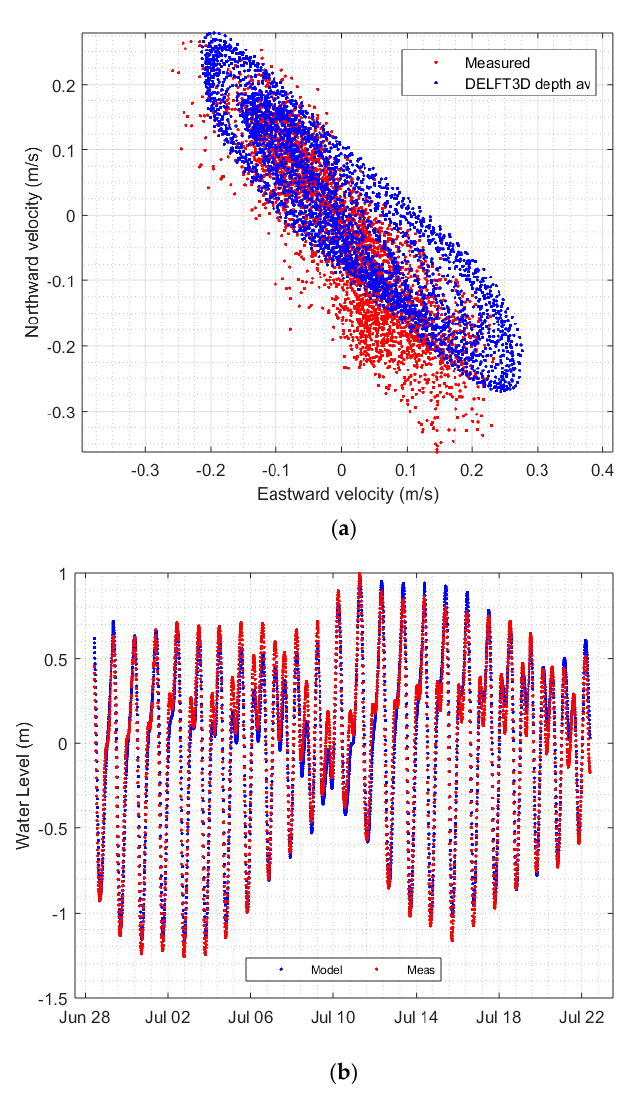
Figure 6. ( a ) Northward and eastward velocities measured by the ADCP at 10 m depth (same current meter as [21]; red) and depth averaged predictions by Delft3D for the same times (blue), ( b ) longshore velocities: Delft3D predictions (blue) versus measured velocities (red).